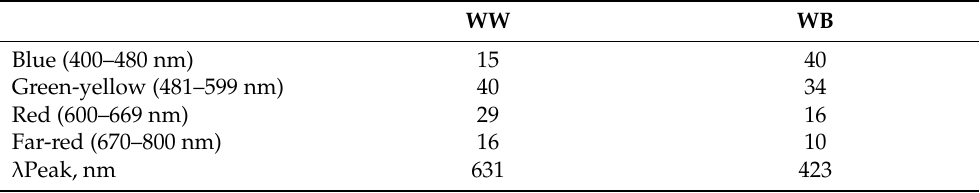
Table 1. Spectral composition (in percentage) of the two light treatments, white light control (WW) and white-blue light (WB), clustered in four main wavelength groups: blue 400–480 nm, green-yellow 481–599 nm, red 600–699 nm, and far-red 670–800 nm, and the indicated light peak ( λ Peak ). WW WB Blue (400–480 nm) Green-yellow (481–599 nm) Red (600–669 nm) Far-red (670–800 nm) λ Peak,